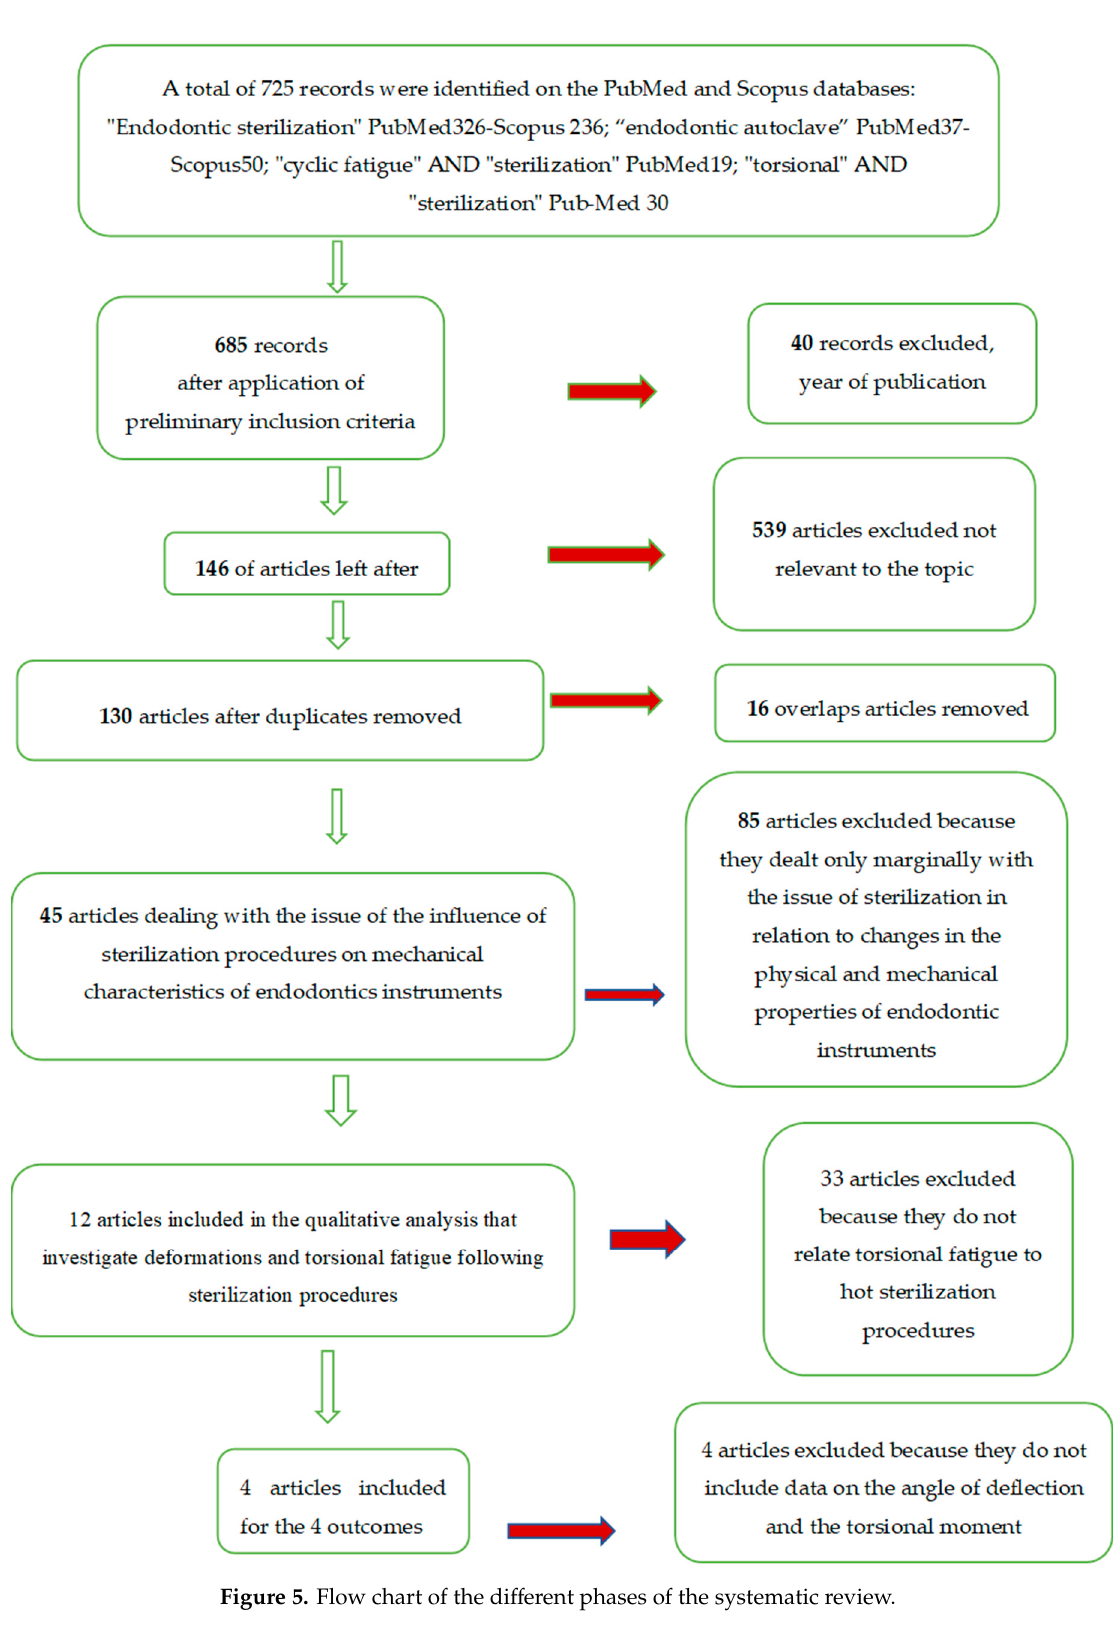
Figure 5. Flow chart of the different phases of the systematic review.